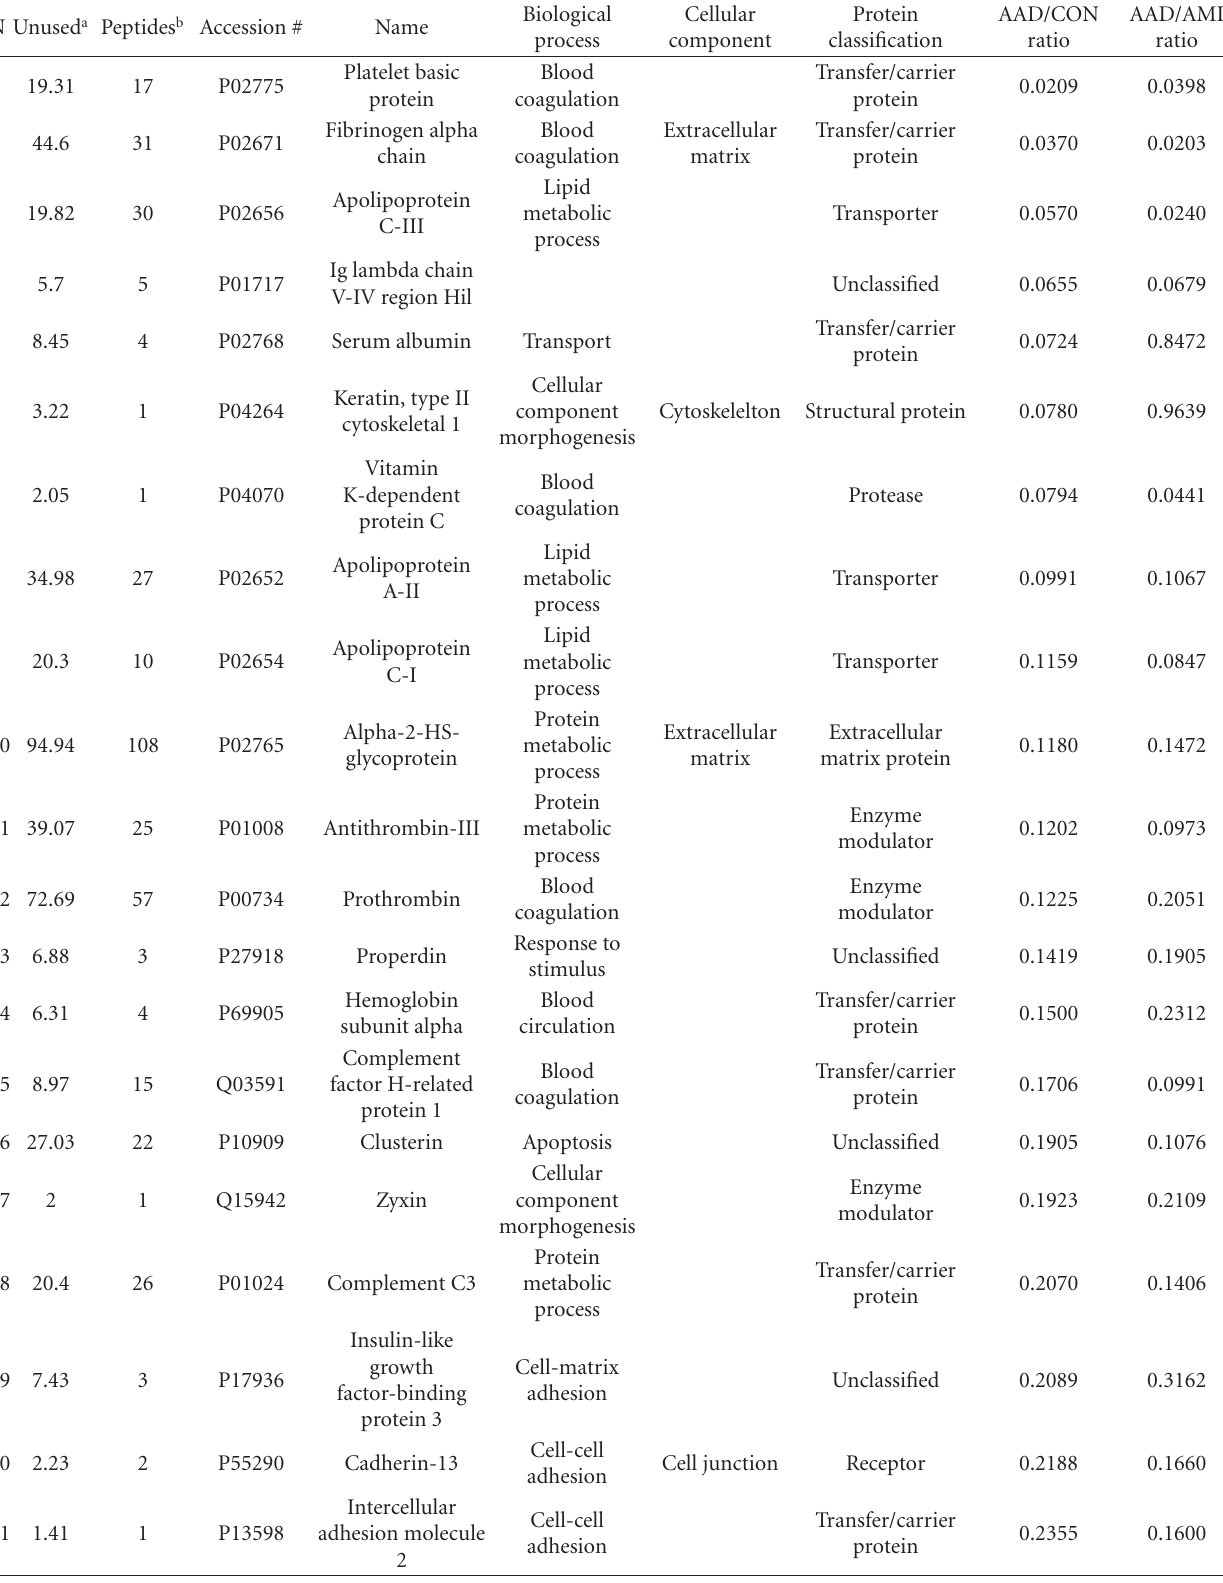
Table 3: List of the decreased ( < 0.5 folds) protein targets identified and their corresponding class, associated biological process, and cellular